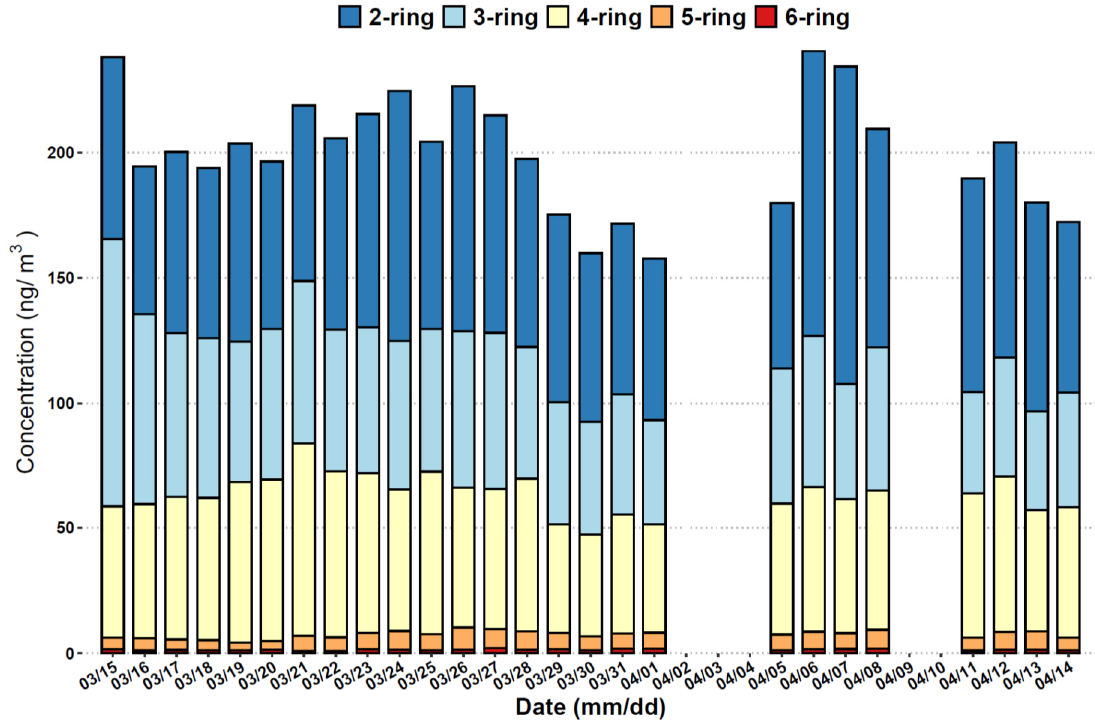
Figure 2. Temporal variations in the concentrations of polycyclic aromatic hydrocarbons (PAHs) with different number of rings during the sampling period. Table 3. Comparison of the total PAHs (ng / m 3 ) at Weizhou Island with some other sites in